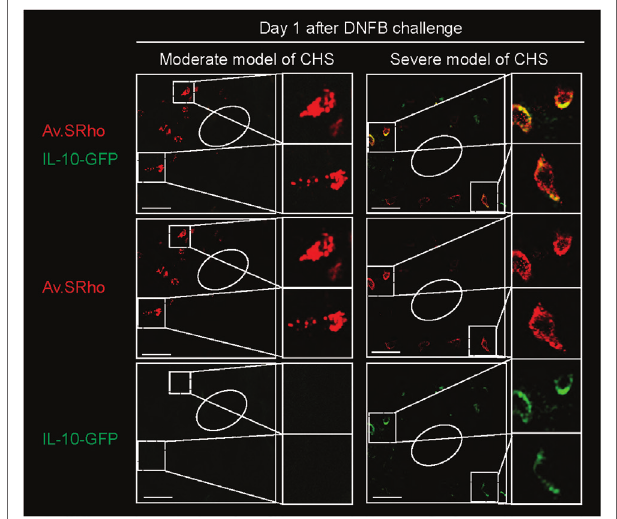
FiGURe 3 | Skin mast cells (MCs) represent an early source of IL-10 during severe contact hypersensitivity (CHS) responses. We used Av.SRho in IL-10-GFP reporter mice to preform a longitudinal monitoring of both the release of dermal MC granules and activation of Il10 gene transcription (IL-10-GFP, as detected by emission of GFP fluorescent signal) at the site of severe CHS responses using intravital 2-photon microscopy. Images show representative 3D photographs of the ear pinna one at day 1 upon DNFB challenge. Upper panel: merged fluorescence of Av.SRho (red) and IL-10-GFP (green). Middle panel: Av.SRho (red) fluorescence. Lower panel: IL-10-GFP (green) fluorescence. White dashed lines identify the magnified areas and white circles identify hair follicles (Scale bars: 50 µm). Adapted from Reber et al. (39).